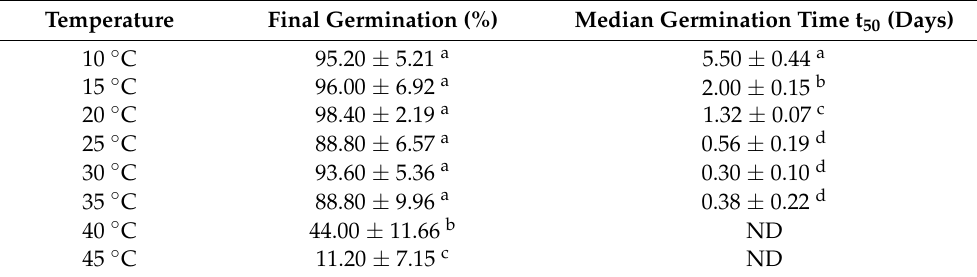
Figure 1. Cumulative germination of S. hispanica at 10, 15, 20, 25, 30, 35, 40, and 45 ◦ C. Values are expressed as mean ± SD of five independent replicates. Statistical analysis was performed using Kruskal-Wallis followed by a Dunn’s multiple comparison test. Table 1. Final germination percent and median germination time (t 50 ) of seeds during imbibition at 10, 15, 20, 25, 30, 35, 40, and 45 °C. Final germination is the percentage of seeds in which the germination process reaches the end; while median germination time (t 50 ) is the time to reach 50% of final germination.